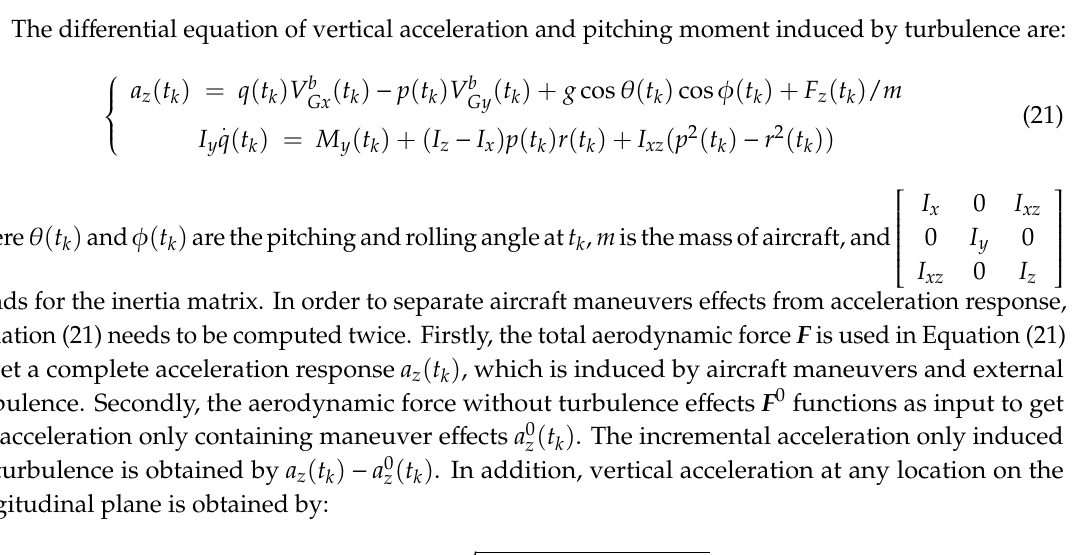
Figure 4. Neighboring rings for a vortex ring.